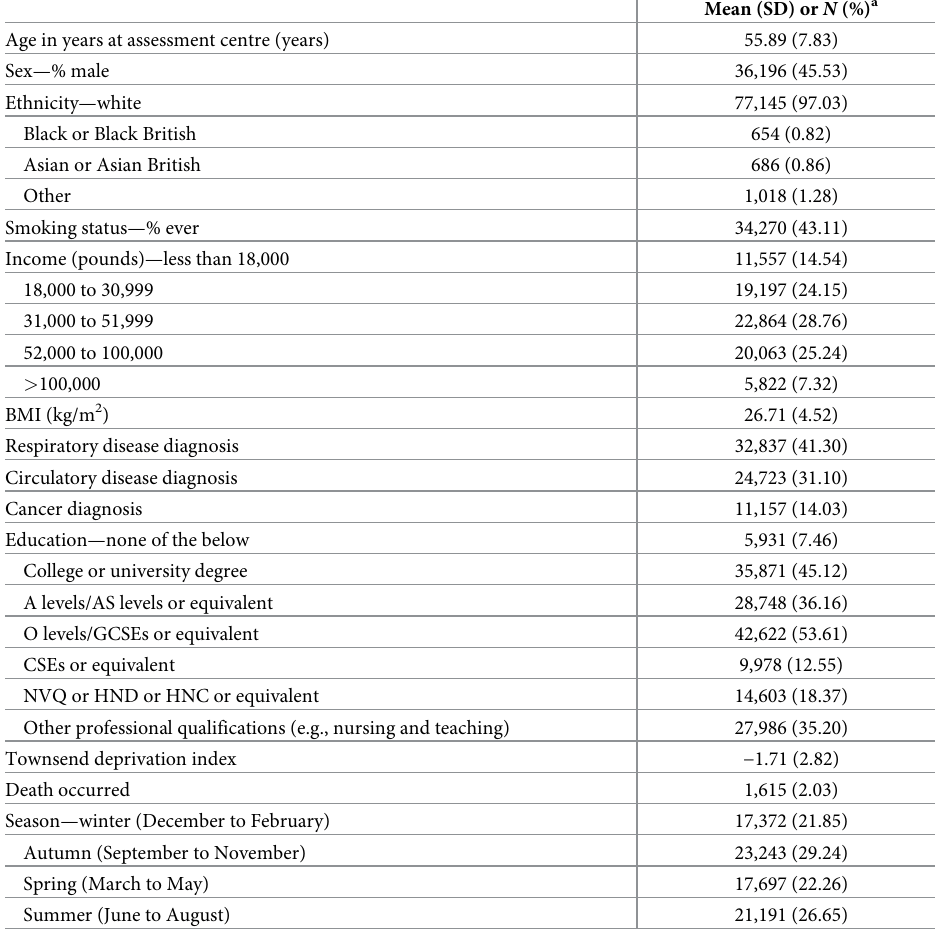
Table 1. Summary statistics of the UK Biobank participants in our